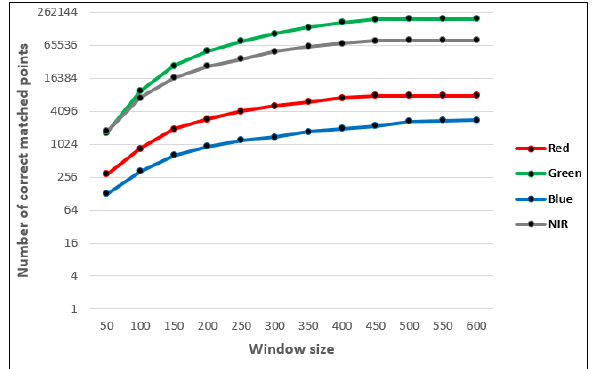
Figure 17. The number of correct matched points based on the window